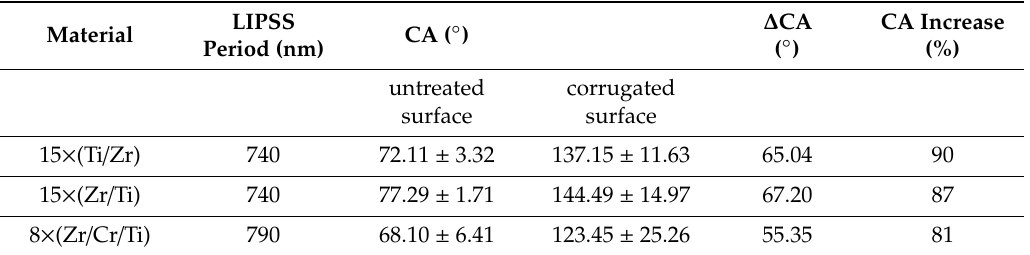
Table 1. The LIPSS period of the sample materials and the CA